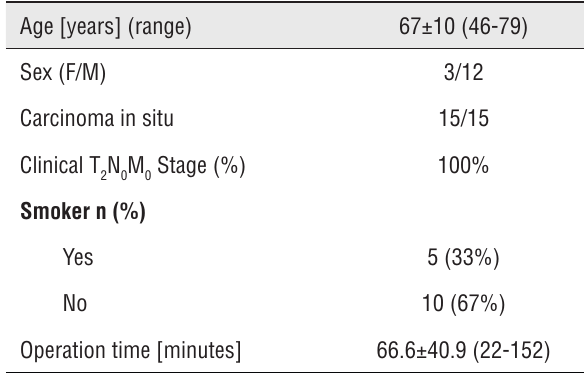
Table 1 - Patient characteristics.